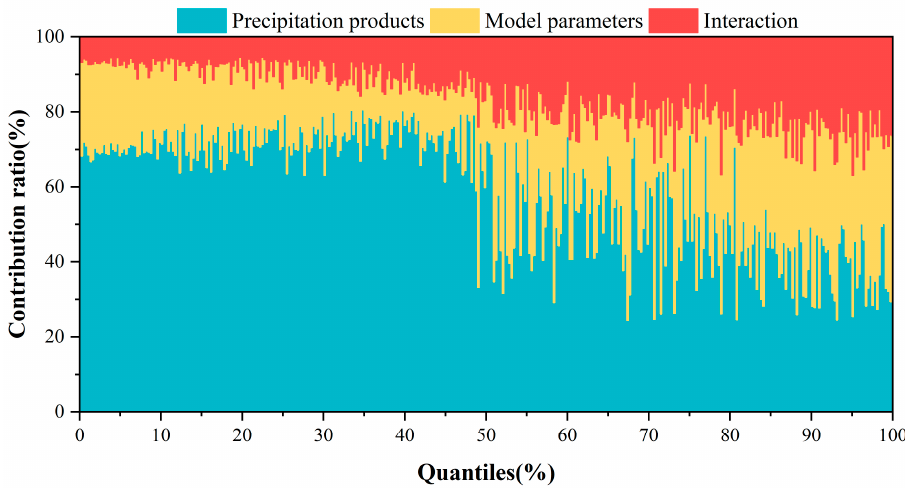
Figure 11. The contribution ratio (%) of the precipitation products, model parameters, and their interaction to the total uncertainty of the streamflow simulation at different quantiles.